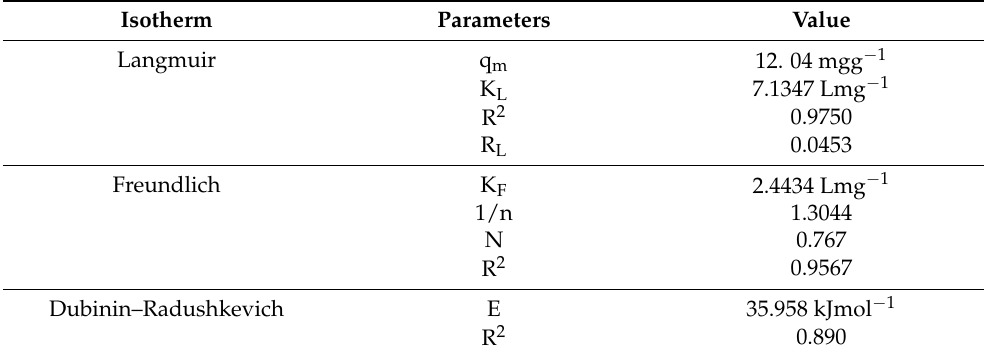
Table 3. Adsorption isotherm constants for adsorption of MV2B on NiO/PDA (0.05 g). (MV2B) 0 = 2.95 mg L − 1 at 30 ◦